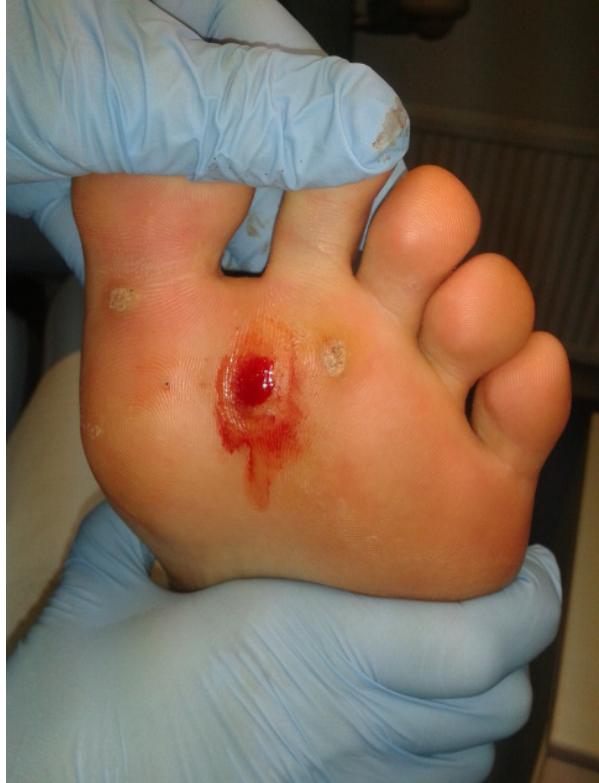
Figure 2. Wart. Immediately post-operatively after undergoing